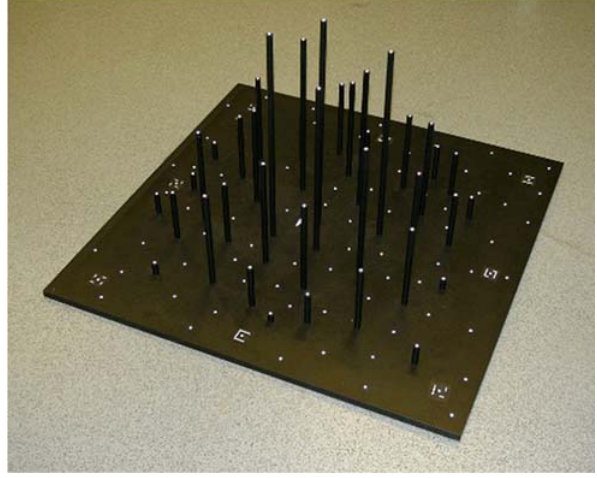
Figure 4. ‘Manhattan’ 3D test object.